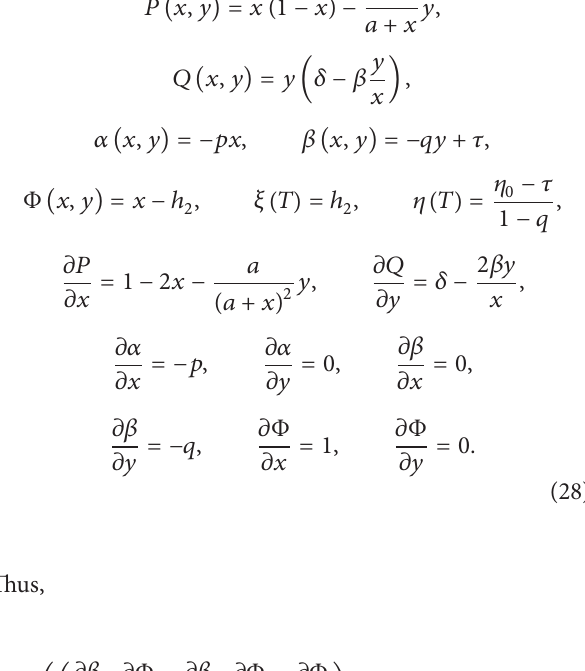
, 𝑦 ) . Then one has the 𝑄 + 1 1